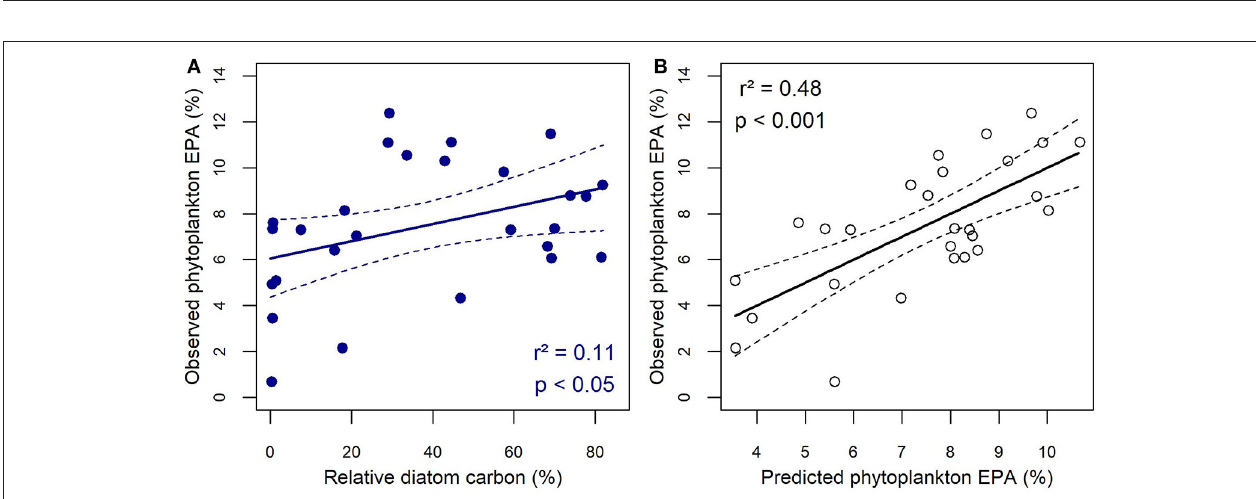
FIGURE 6 | Relationship between the relative contribution of EPA measured in particulate organic matter at the SCM and (A) the relative carbon biomass of diatoms and (B) the EPA contribution predicted by a multiple regression model that includes diatom carbon and latitude as independent variables. The dashed lines represent the 95% confidence